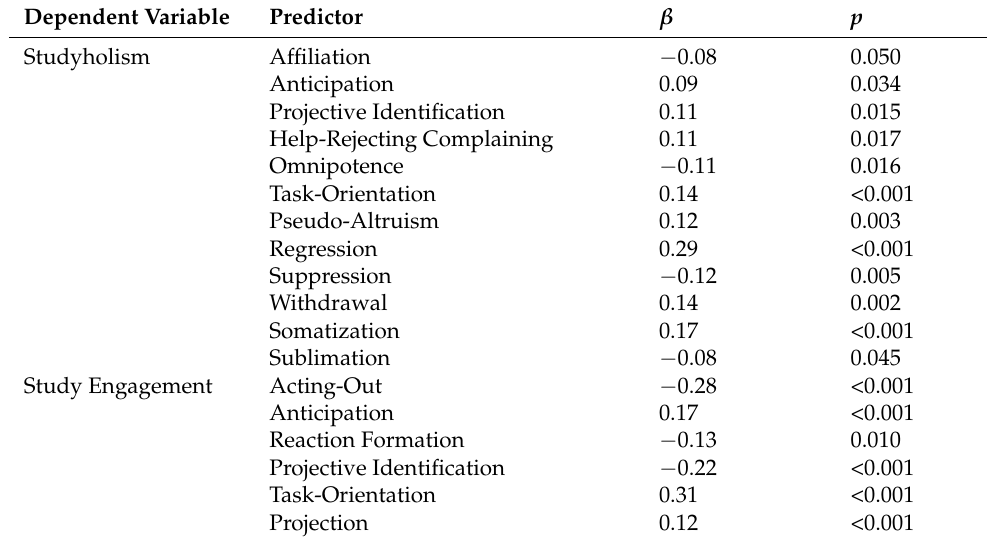
Table 3. Standardized path weights for the statistically significant predictors ( n =